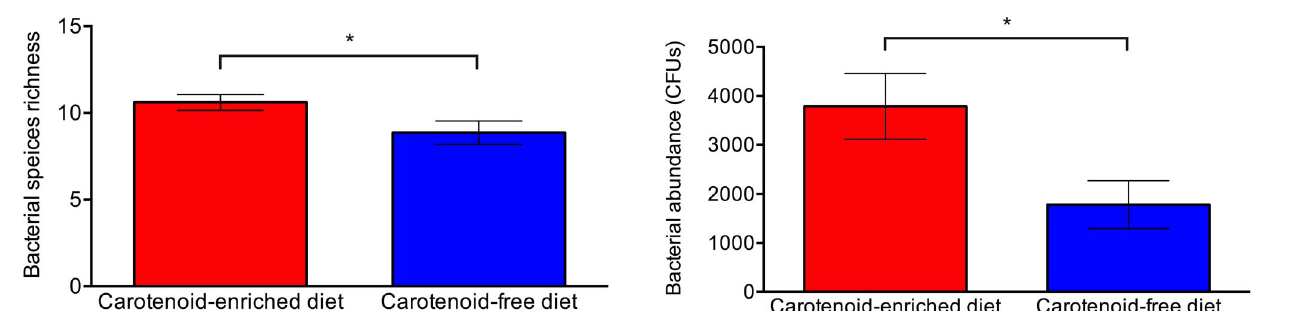
Figure 2. Average bacterial abundance (number of colony forming units (CFUs) isolated from each individual) of the culturable bacterial community associated with the skin of Agalychniscallidryas fed on a carotenoid-enriched and caroten- oid-free diet. Error bars show 6 1 S.E.M. An *indicates a significant difference.